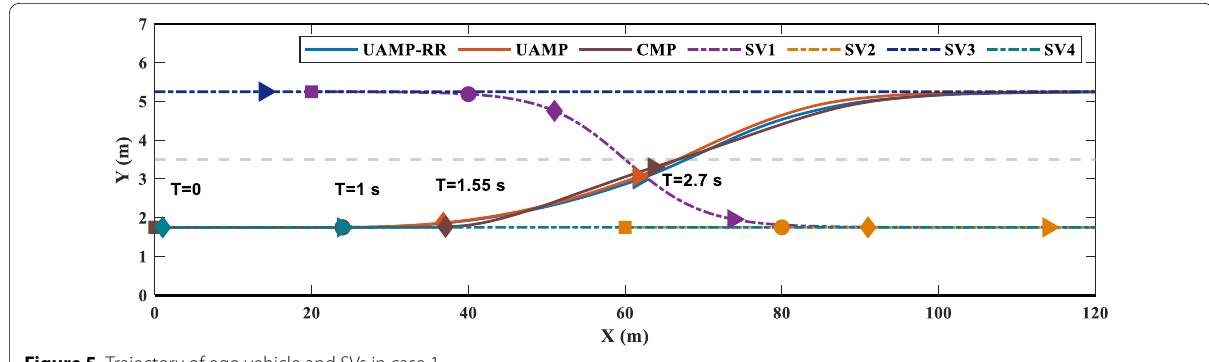
Figure 5 Trajectory of ego vehicle and SVs in case